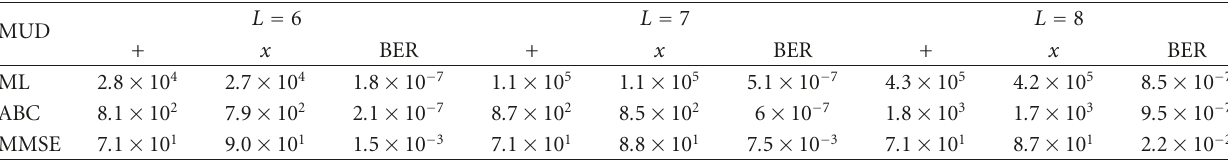
Table 3: Comparison of MUD